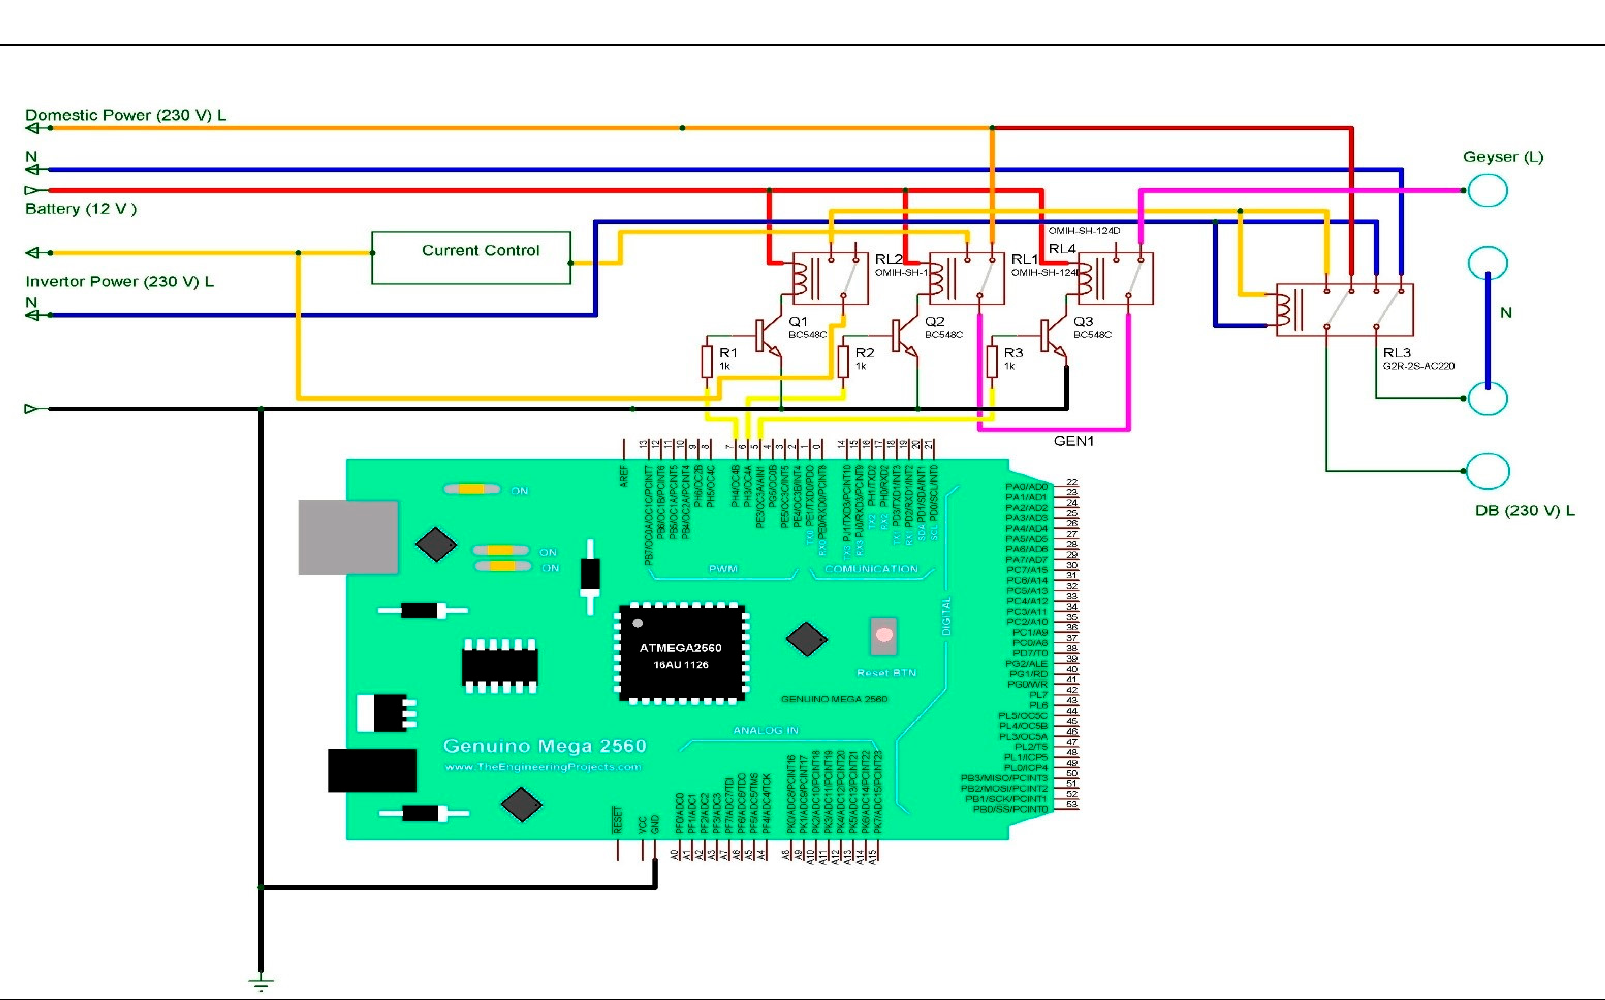
Figure A1. Schematic diagram of the complete controlling circuit.